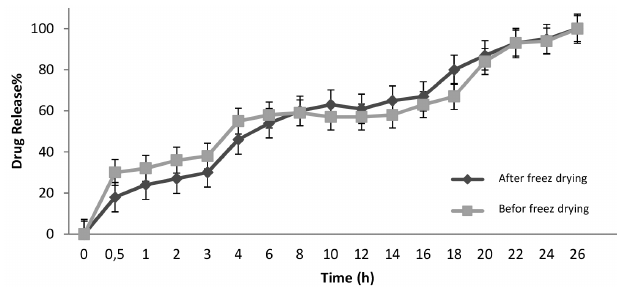
FIGURE 3 - Release profile of ampicillin solid lipid nanoparticles before and after